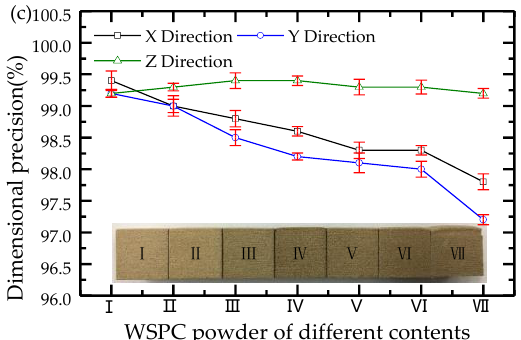
Figure 6. WSPC parts and change curves of dimensional precision of the WSPC parts: ( a ) walnut